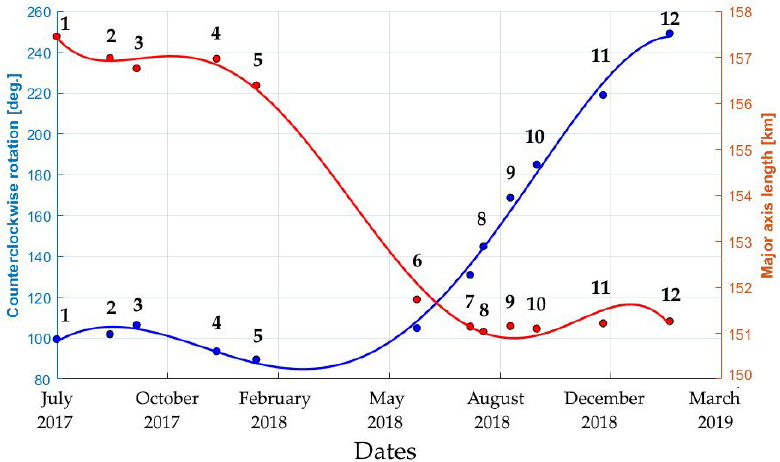
Figure 7. Angle and major axis length progression. Based on a polynomial least-squares regression, a 5th-degree polynomial curve fits the series of data points. The blue and red curves display the long-term tendency of rotation angle and major axis length.